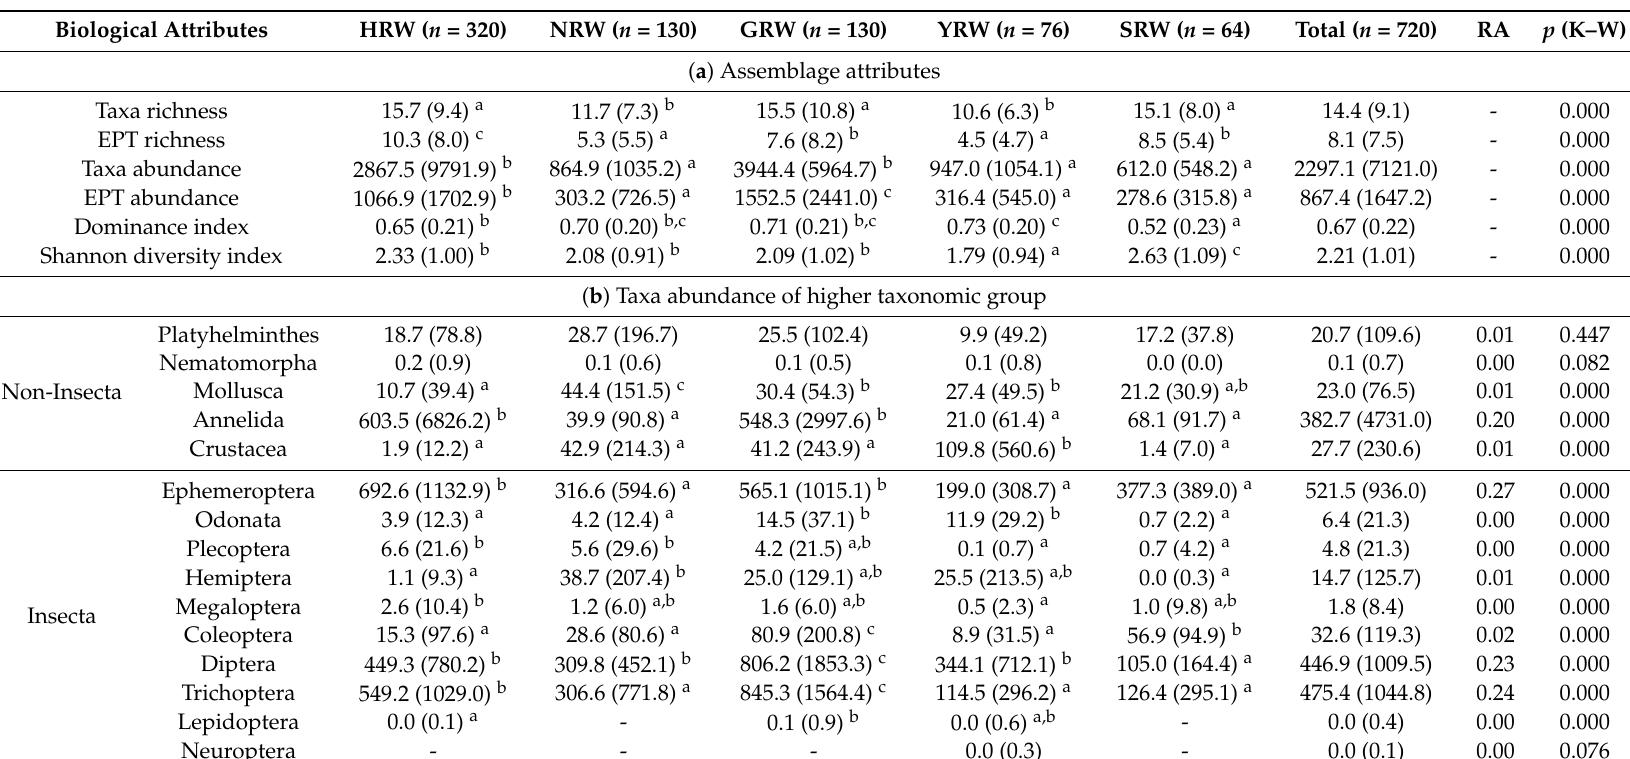
Table 2. Assemblage attributes ( a ) and average abundance (individuals ¨ m ´ 2 ) ( b ) of benthic macroinvertebrates with standard deviation (in parenthesis) in five major river watersheds: the Han River (HRW), Nakdong River (NRW), Geum River (GRW), Youngsan River (YRW), and Seomjin River Watershed (SRW). Relative abundance (RA) indicated as an average of total density for each taxonomic group. Kruskal–Wallis test (K–W) was performed for each taxonomic group. The same small letters indicate no significant difference based on Dunn’s multiple comparison